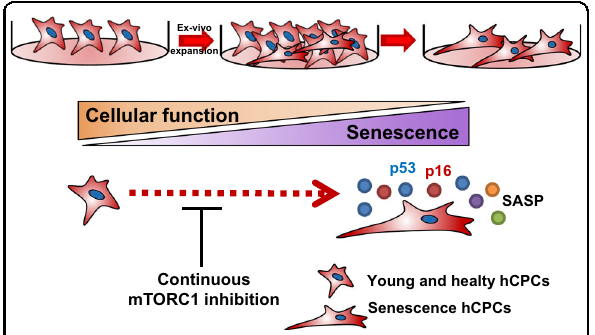
Fig. 8 Prolonged rapamycin treatment attenuates replicative senescence and improves cellular function in hCPCs. We initially generated cellular replicative senescence in hCPCs and characterized the molecular and physiological phenotype of replicative senescence in hCPCs. Furthermore, pharmacological inhibition of mTOR by rapamycin can attenuate replicative cell senescence and improve cellular function in